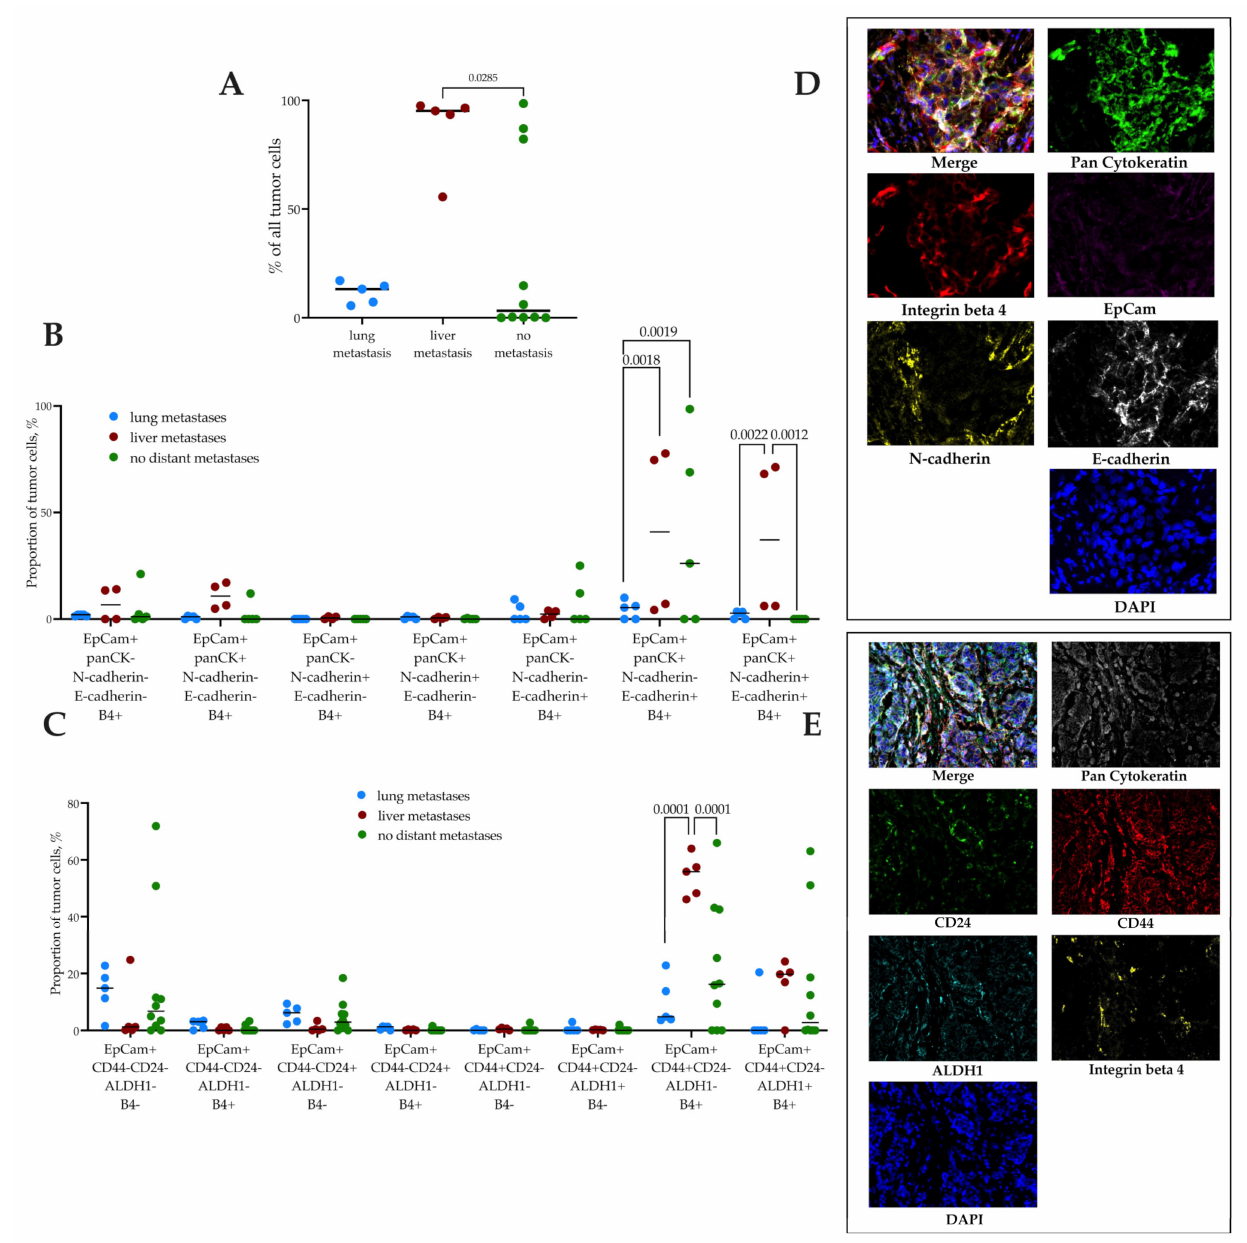
Figure 3. ( A ) Proportion of tumor cells expressed β 4 integrin in breast cancer patients with distant metastases in different organs. ( B ) Proportion of integrin β 4+ tumor cells with EMT features in breast cancer patients with distant metastases in different organs. ( C ) Proportion of integrin β 4+ tumor cells with stemness features in breast cancer patients with distant metastases in different organs. ( D , E ) EMT (E-cadherin and N-cadherin) and stem (CD44+CD24- and ALDH1) markers in Integrin beta 4-positive tumor cells in breast cancer patients (Multiplex IHC, ( A )—magnification 630 × , ( B )—magnification 400 × ). Samples were tested for statistical outliers, then one-way ANOVA was used to compare the means of independent